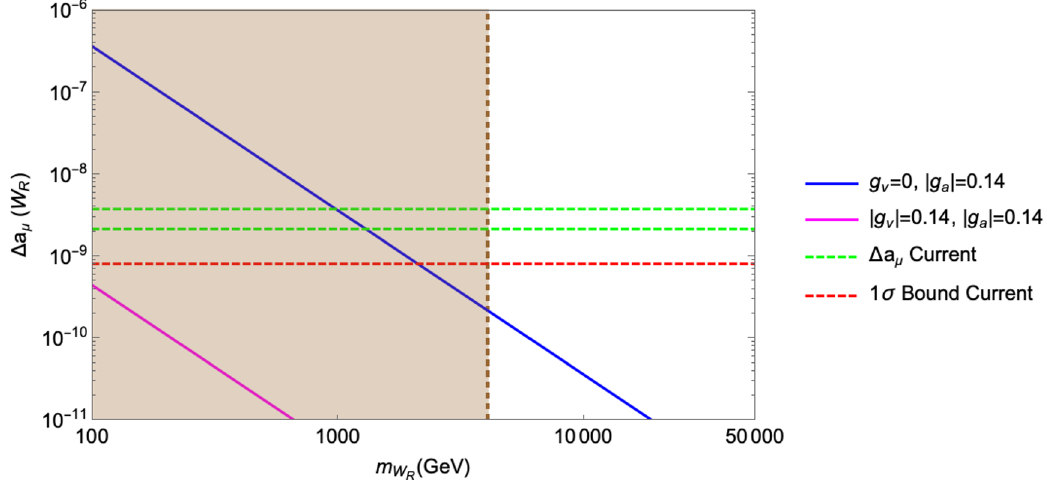
Figure 8 . Plot showing the contribution of charged vector boson W R to (cid:1) a (cid:22) for the case g L The blue line represents the contribution of W R when purely axial vector-like coupling is considered and it is sensitive to current bound on (cid:1) a (cid:22) when W R mass lies around 1 TeV. The magenta line represents the contribution when both vector-like and axial vector-like couplings are considered non-zero which is sensitive to the current bound on (cid:1) a (cid:22) for mass range < 100 GeV but these two cases do not even satisfy the bound on W R mass (as they both appear within the brown shaded excluded mass